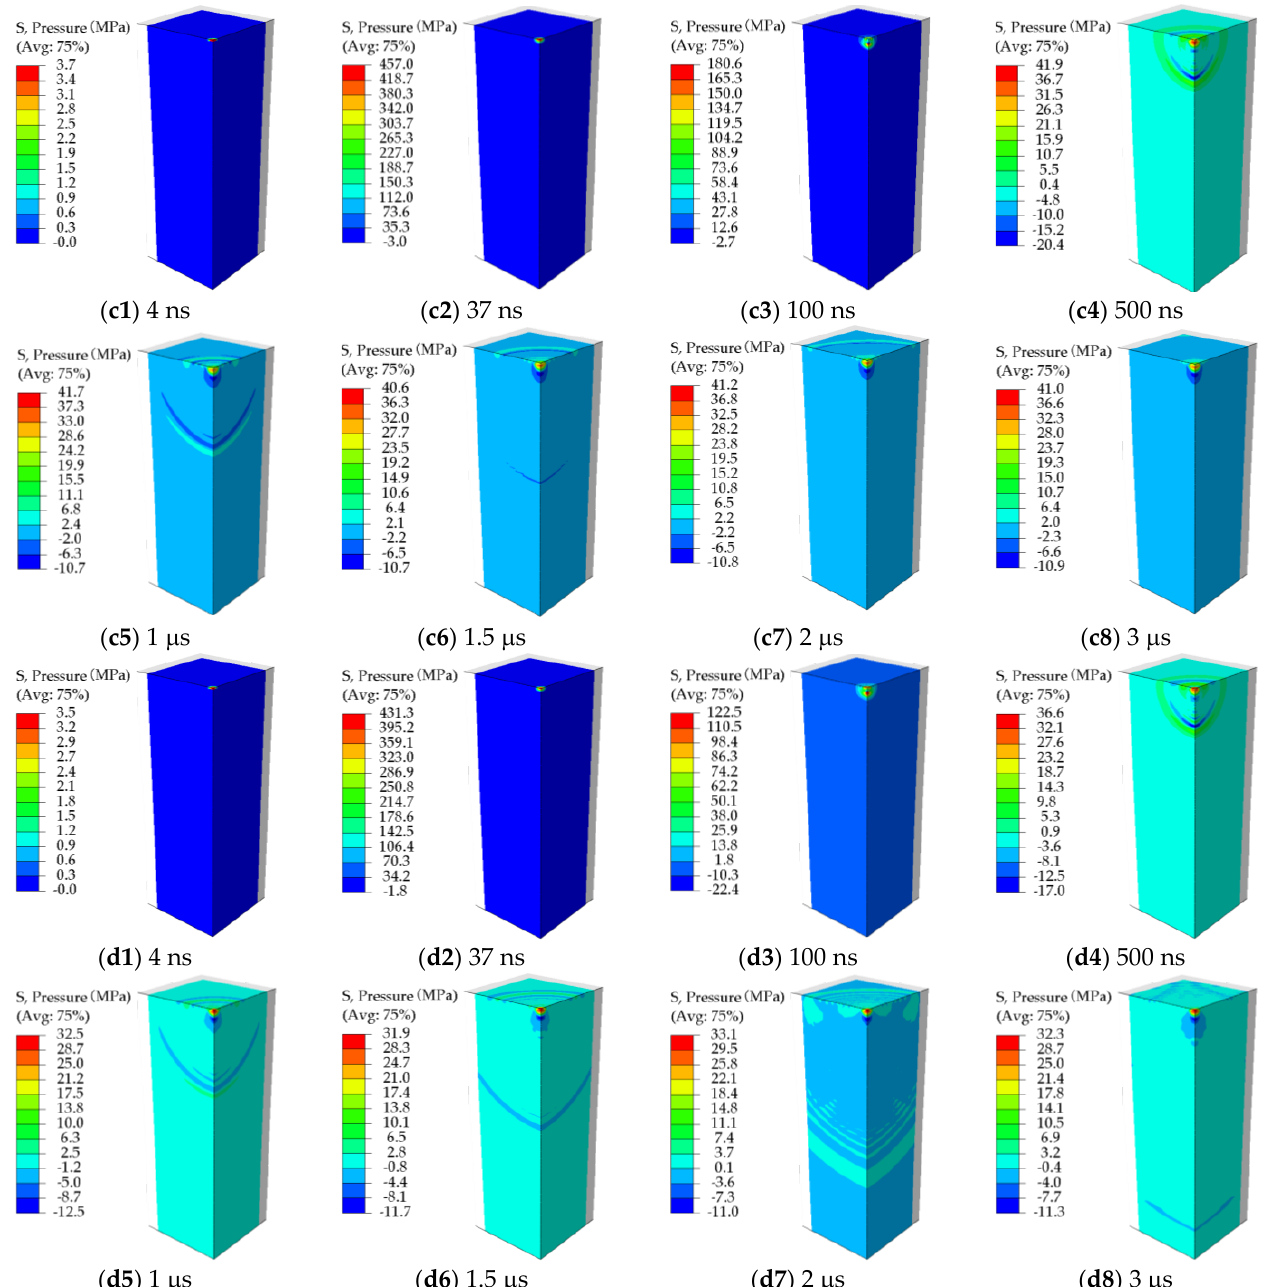
Figure 5. Propagation and attenuation of the LSP-induced shock wave: ( a1 – a8 ) Uniform distribution of laser plasma-induced shock wave pressure in the case of P max = 2.0GPa& D = 8.0mm; ( b1 – b8 ) Gaussian distribution of laser plasma-induced shock wave pressure in the case of P max = 2.0GPa& D = 8.0mm; ( c1 – c8 ) Uniform distribution of laser plasma-induced shock wave pressure in the case of P max = 0.6GPa& D = 0.8mm; ( d1 – d8 ) Gaussian distribution of laser plasma-induced shock wave pressure in the case of P max = 0.6GPa& D =